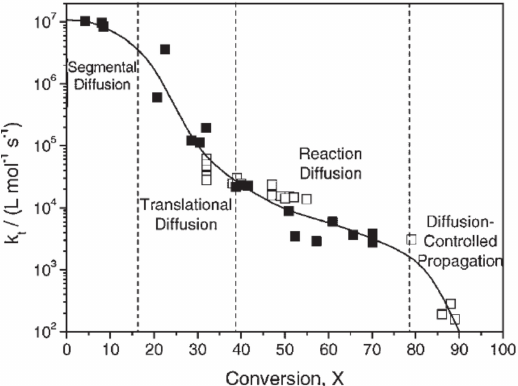
Figure 19. Termination rate coefficient k t vs. conversion for methyl methacrylate at 0 ◦ C ( (cid:4) ) and 50 ◦ C ( (cid:3) ). Reprinted from reference [84] with the permission of John Wiley and Sons.